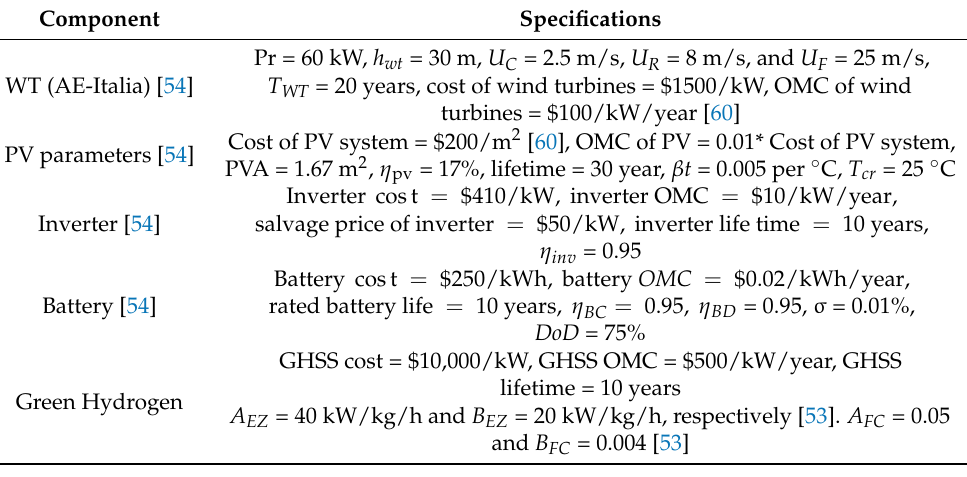
Figure 9. The variation of the EV charging load during day hours for a complete year. Table 3. The specifications of different HRES components.